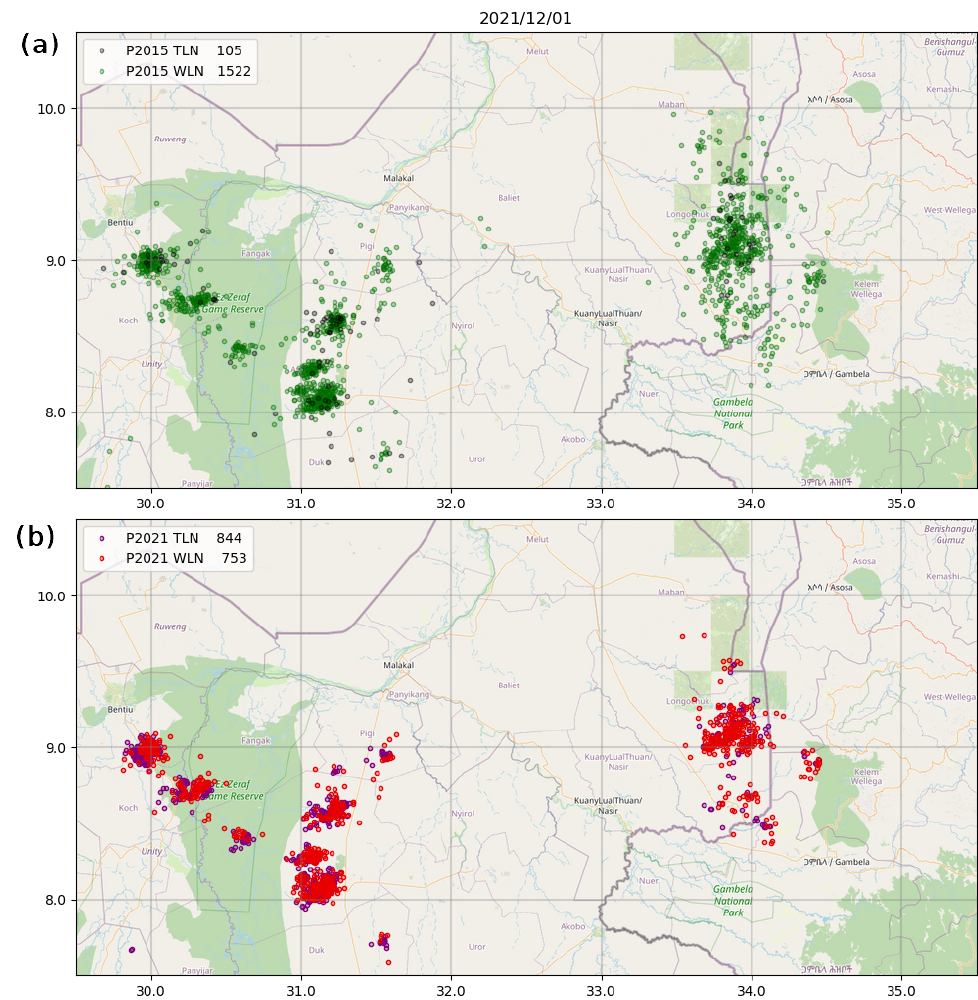
Figure 4. Locations of lightning in South Sudan for one case study. ( a ) ENTLN (black circles) and WWLLN (green circles) locations from P2015; ( b ) ENTLN (purple circles) and WWLLN (red circles) locations from